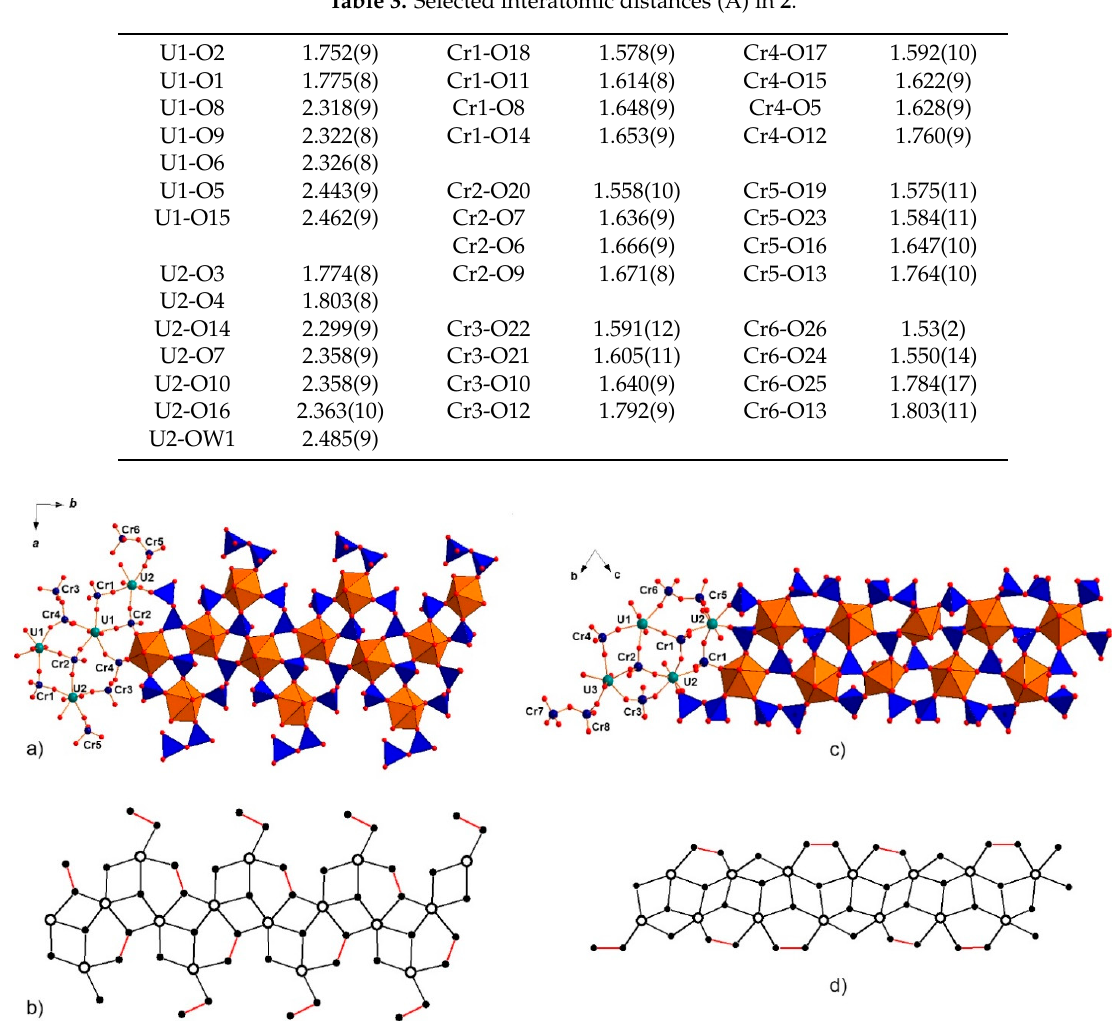
Figure 3. Ball-and-stick and polyhedral representation of [(UO 2 ) 2 (CrO 4 ) 2 (Cr 2 O 7 ) 2 (H 2 O)] 4 − and [(UO 2 ) 6 (CrO 4 ) 8 (Cr 2 O 7 ) 4 ] 12 − uranyl-dichromate units in the structures of 2 ( a ) and 3 ( c ), respectively (designations: UO 7 = orange; CrO 4 = blue).Black-and-white graphs (U = white circles, Cr = black circles) of [(UO 2 ) 2 (CrO 4 ) 2 (Cr 2 O 7 ) 2 (H 2 O)] 4 − ( b ) and [(UO 2 ) 6 (CrO 4 ) 8 (Cr 2 O 7 ) 4 ] 12 − ( d ) one-dimensional units. Red single lines highlight Cr 2 O 7 groups. Table 3. Selected interatomic distances (Å) in 2 .